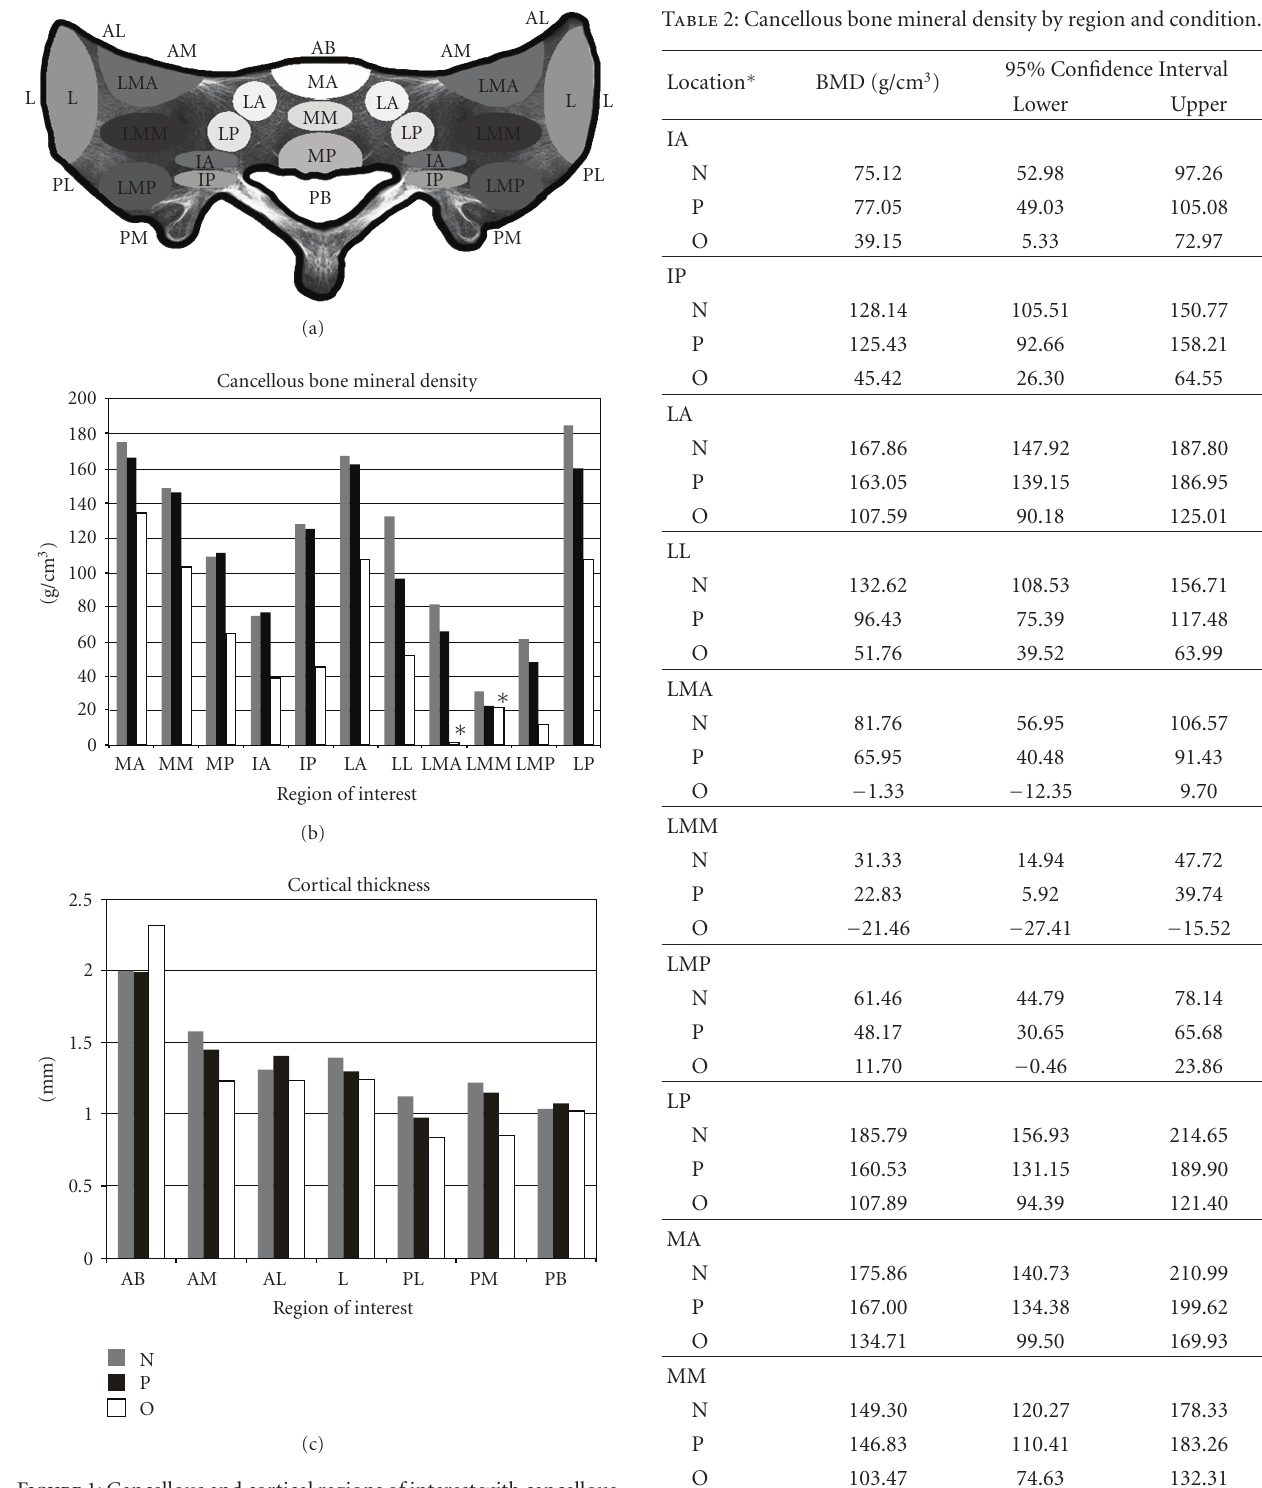
Figure 1: Cancellous and cortical regions of interest with cancellous bone density and cortical thickness. (a) Letter outside the sacrum represents the location of cortical measurements on each slice; the inside letters and ovals represent the cancellous regions of interest. (b) Bone mineral density by region of interest for the normal, osteopenic, and osteoporotic groups. (c) Cortical thickness by region of interest for the normal, osteopenic, and osteoporotic groups. ∗ negative values (see Table 2).